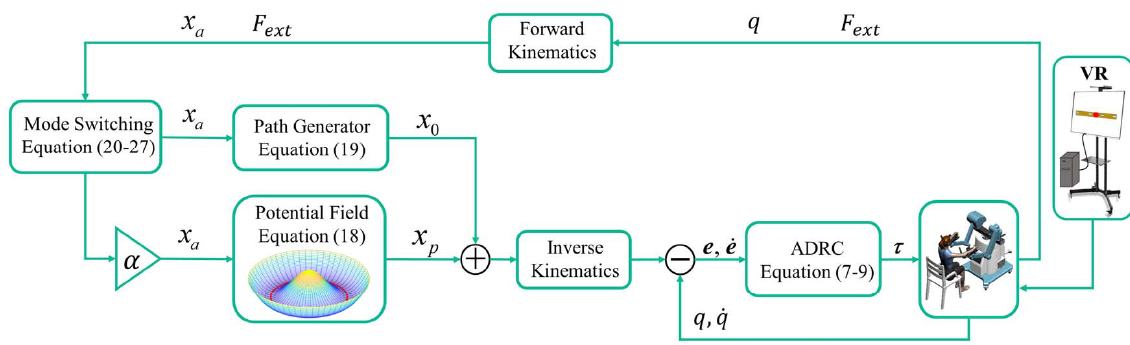
Figure 5. Upper limb rehabilitation robot dual-modal hybrid self-switching control block